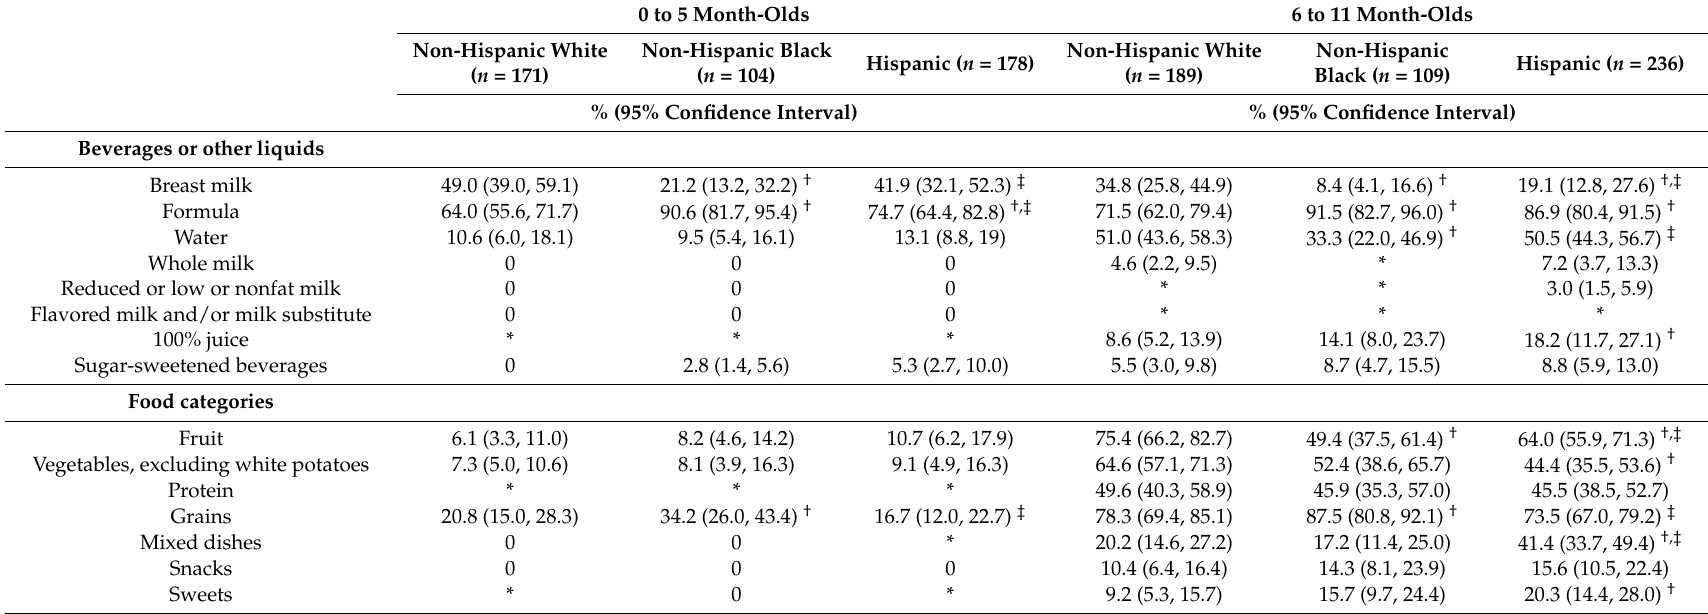
Table 3. Percentage of U.S. children birth to 23 months of age 1 consuming any beverages or other liquids and different food categories 2 by age and race/Hispanic origin 3 , NHANES